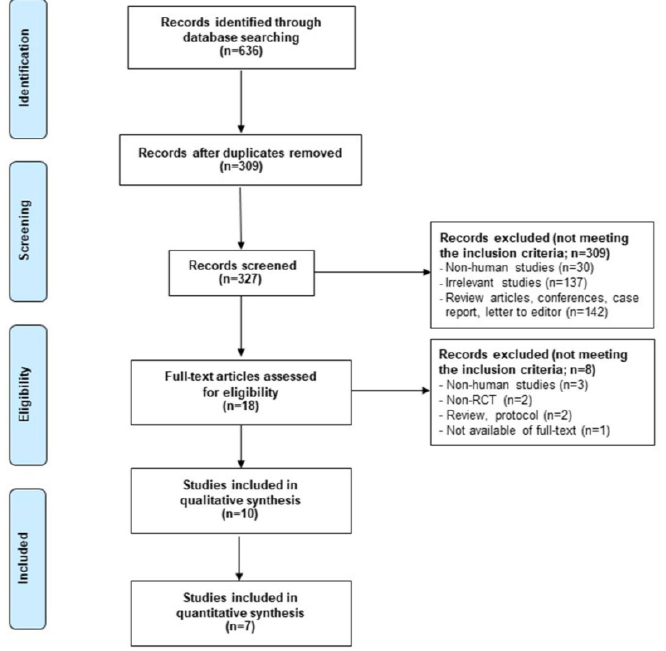
Figure 1. PRISMA flow diagram of study selection for the systematic review and meta-analysis .